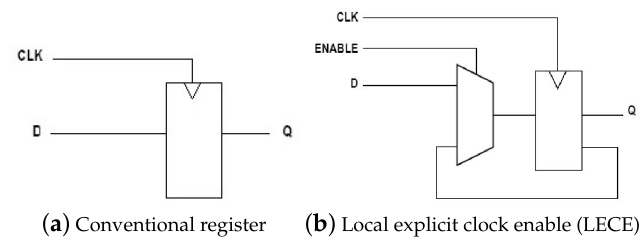
Figure 3. Conventional register versus register with local explicit clock Enable